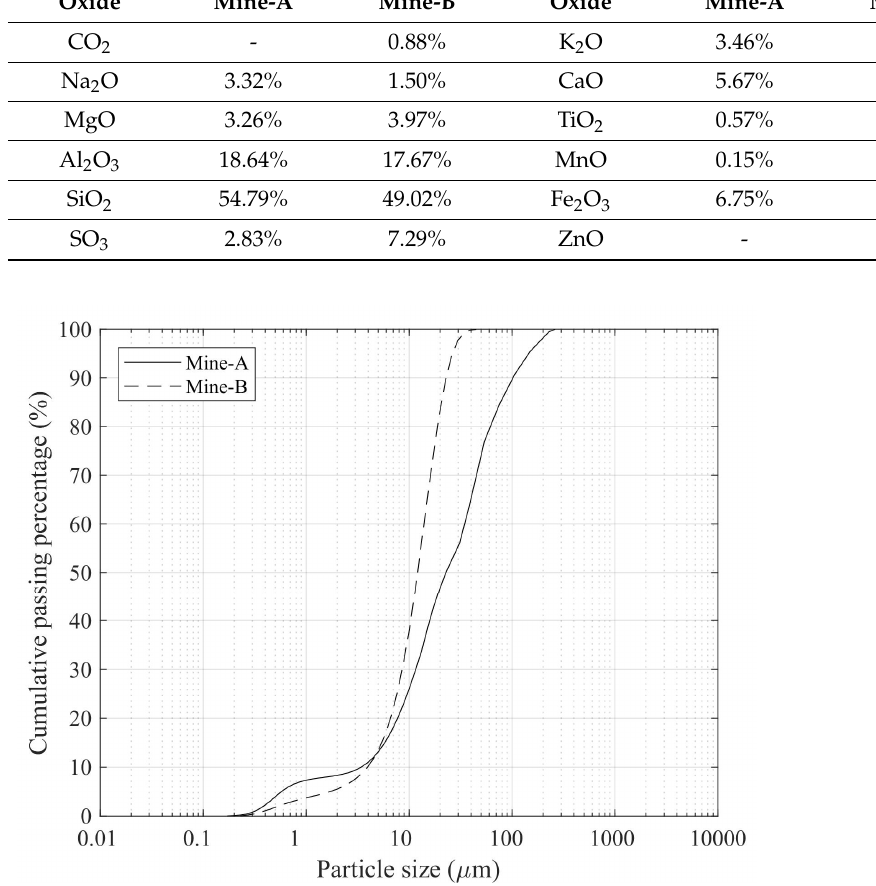
Figure 1. Mine-A and Mine-B particle size distribution. A sample of the highest solid concentration is mixed from thickened tailings and pro- Table 2. Mine-A and Mine-B tailings cessed mine water for every test. The sample is then gradually diluted by adding more water for subsequent tests. A sample is weighed and dried in an oven at each solid con- centration to determine the exact solid fraction of the sample used in each trial. The sam- ples used in this study for Mine-A and Mine-B are detailed below in Tables 3 and 4, along with the type of experiment performed with them, rheometer sensors, cup types, and tem- peratures. The HAAKE Viscotester 550 was used with MVDIN and SVII sensors for cup and bob tests and FL100 vane sensor for yield stress. Standard and infinite cup mediums